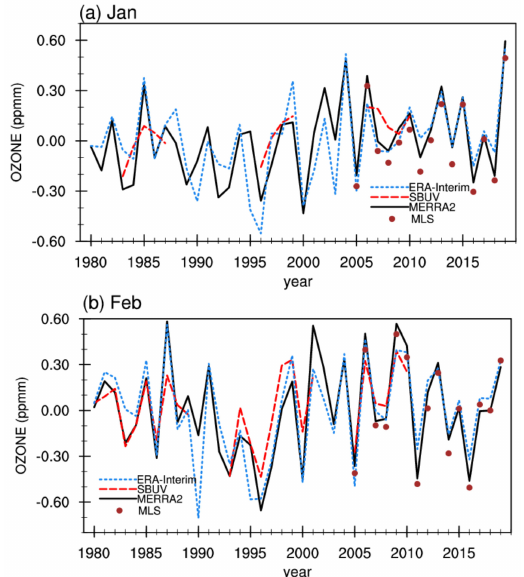
Figure 1. Time series of the anomalies of ozone concentrations (unit: ppmm) in the lower stratosphere over the Arctic (60–90 ◦ N; 30–300 hPa) derived from the ERA-Interim (blue), SBUV (red), MERRA-2 (black), and MLS (brown circles) databases in ( a ) January and ( b ) February during